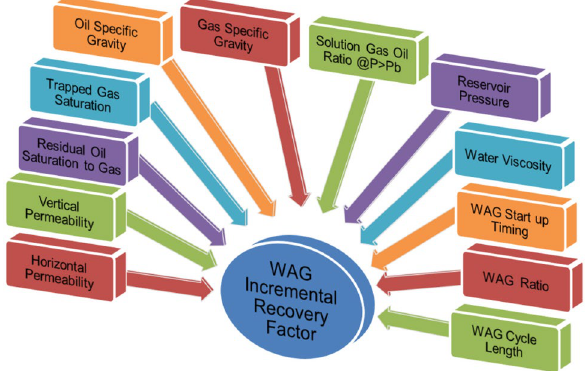
Fig. 2 Selected variables for WAG incremental recovery factor pre-